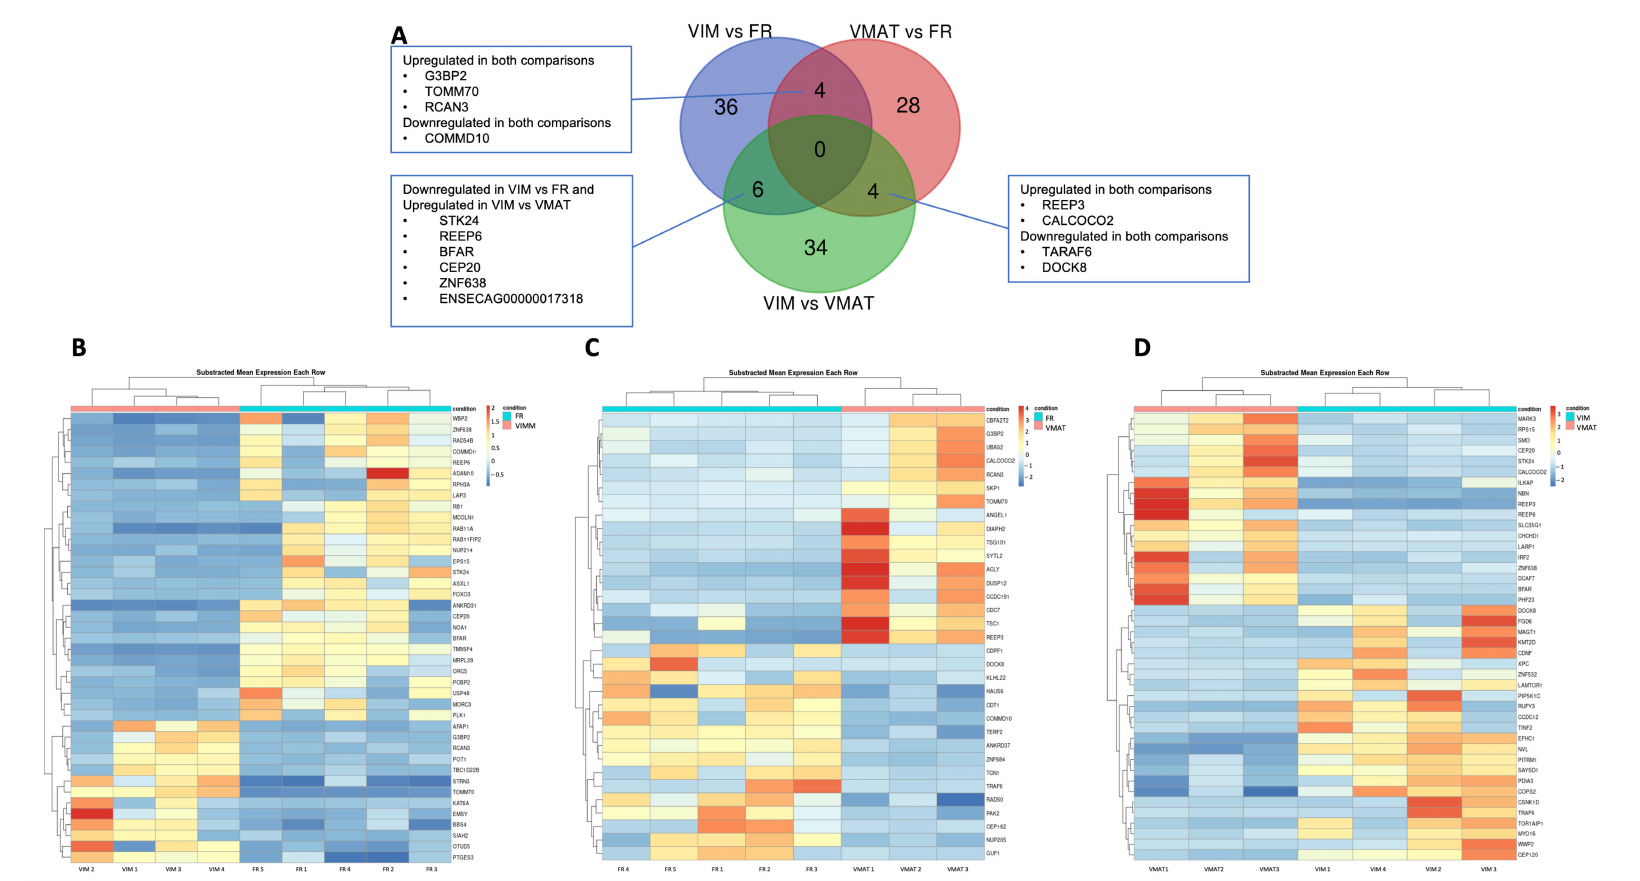
Figure 3. Vitrification at different meiotic stages alters transcriptomics. This figure represents the differentially expressed (DE) genes for three groups: (1) fresh in vitro matured oocytes as a control (FR), (2) oocytes vitrified after in vitro maturation (VMAT), and (3) oocytes vitrified immature, warmed, and in vitro matured (VIM). ( A ) Venn diagram shows the DE genes that overlap between comparisons and the ones specific to each comparison. ( B ) Heatmap generated by the clustering of the DE genes between VIM vs. FR. ( C ) Heatmap generated by the clustering of the DE genes between VMAT vs. FR. ( D ) Heatmap generated by the clustering of the DE genes between VIM vs. VMAT. In the Venn diagram DE categorization (i.e., up or downregulation) is associated with the first factor in the comparison. For all heatmaps, red is upregulation and blue is downregulation, as compared to the mean expression over all